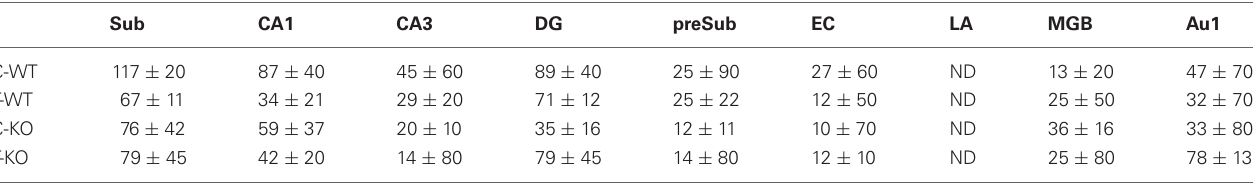
FIGURE 3 | FosB/ (cid:2) FosB immunostaining in acoustic structures after exposure to the test for audiogenic seizure induction and in relation with the mouse genotype (WT vs . Fmr1 KO) at P45. (A) Bar graphs of cellular density based on counts of FosB/ (cid:2) FosB-immunopositive cell nuclei per mm 2 in the MGB and Au1. ∗ P < 0 . 05, ∗∗ P < 0 . 01, acoustically stimulated group vs. the respective unstimulated group; # P < 0 . 05, Fmr1 KO vs. WT Table 1 | Cellular density based on count of FosB/ (cid:2) FosB-immunopositive cell nuclei per mm 2 in Fmr1 KO and WT mice studied at age